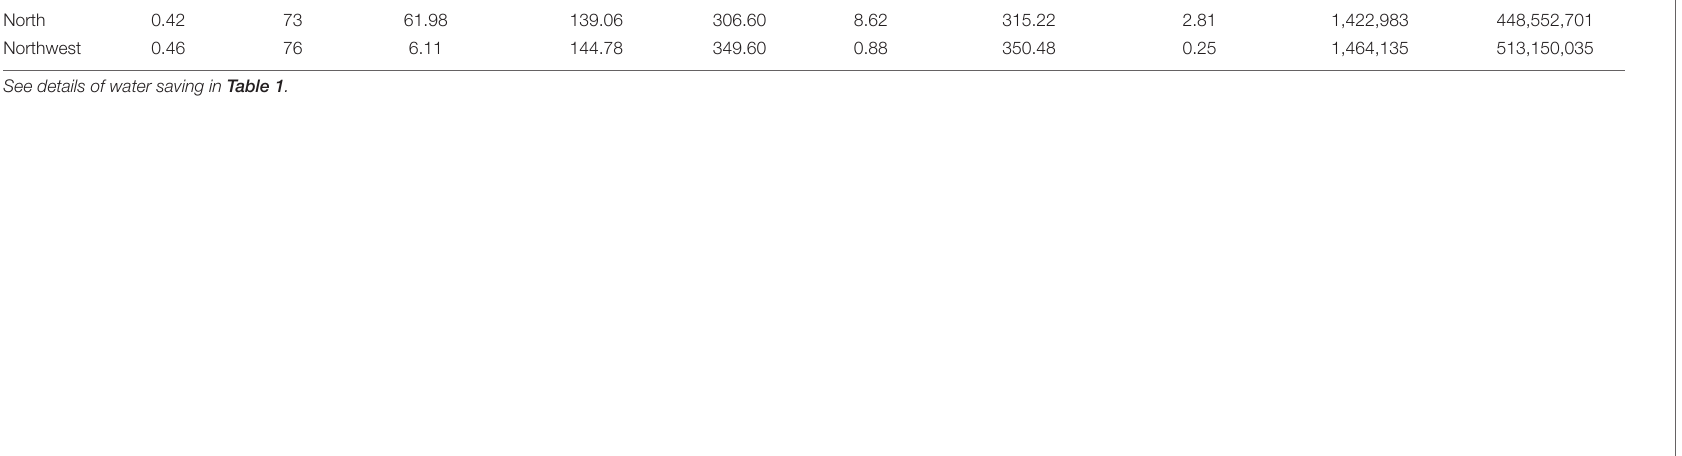
TABLE 6 | Estimated mean nitrogen saving (NS) or nitrogen saving value (NSV) and corresponding economic benefits in a specific region (refer to Figure 1 ).